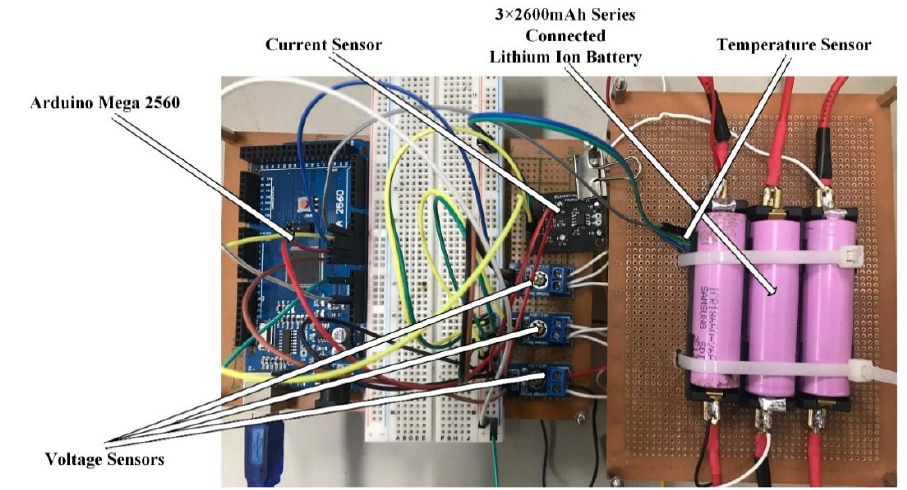
Figure 6. Hardware configuration of the fast-charging system.